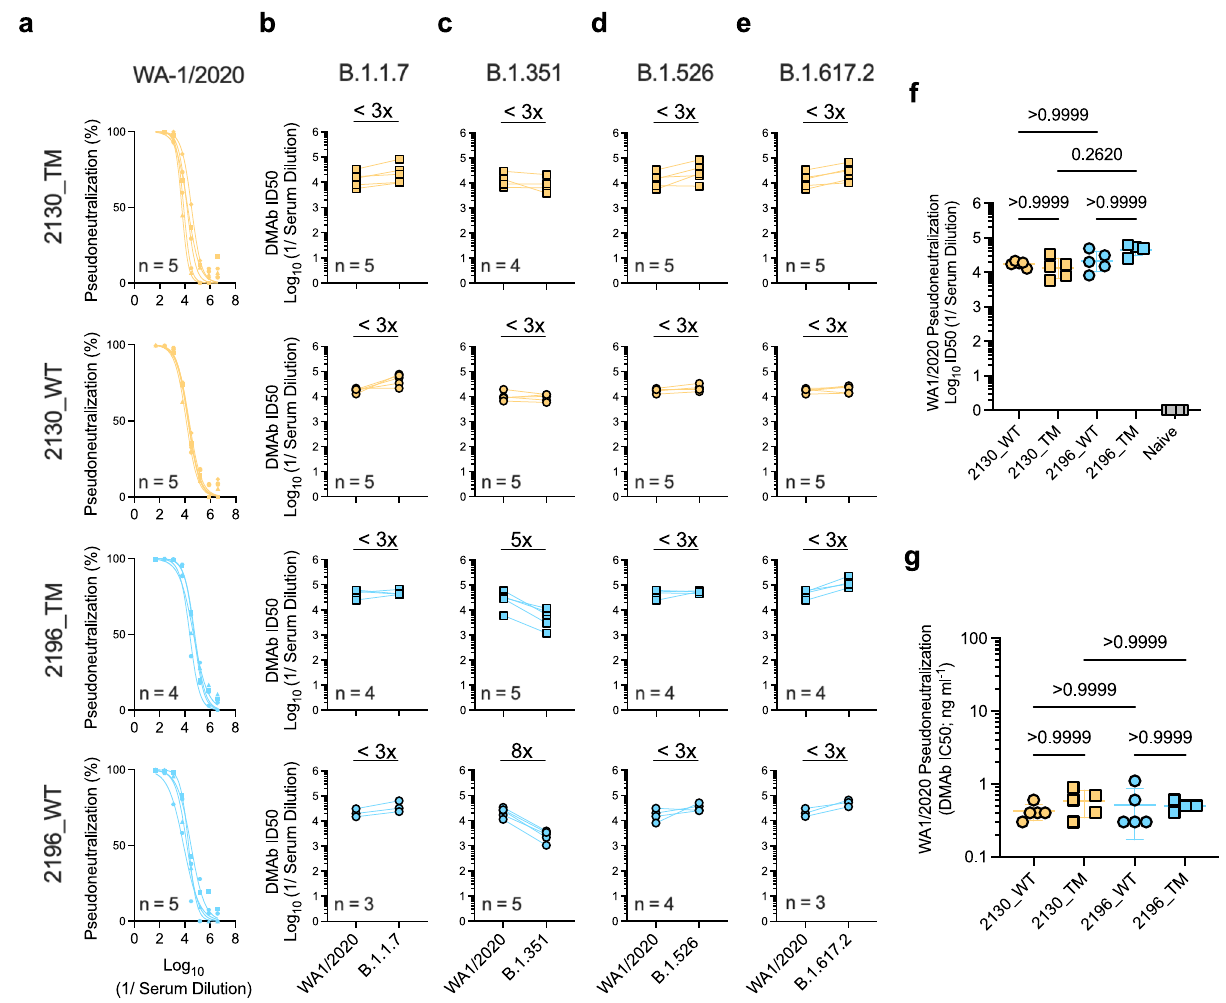
Fig. 2 | In vivo-launched 2196- and 2130-based DMAbs retain activity against major SARS-CoV-2 viral variants. Neutralizing activity of sera samples (indepen- dent biological replicates) from DMAb-administered mice ( n =3 – 5/group, as indi- cated) against a USA-WA1/2020 SARS-CoV-2 pseudovirus. Graphs depict neutralization curves for each serasample (best- fi t lines and individual data points derivedfromtechnicalreplicates). b – e Correspondingactivityoftheseseraagainst the indicated variant pseudoviruses. Graphs depict matched ID50s values of each sample against the indicated VoCs compared to USA-WA1/2020. Average fold change (x) in ID50 for each group is indicated for the following SARS-CoV-2